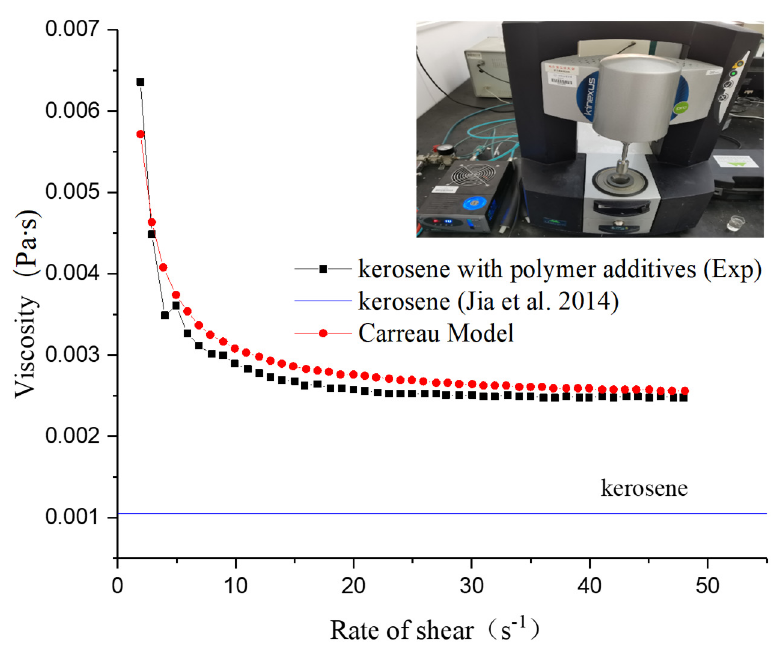
Figure 2. The effect of the shear ratio on the kinematic viscosity for the JZM polymer additive.